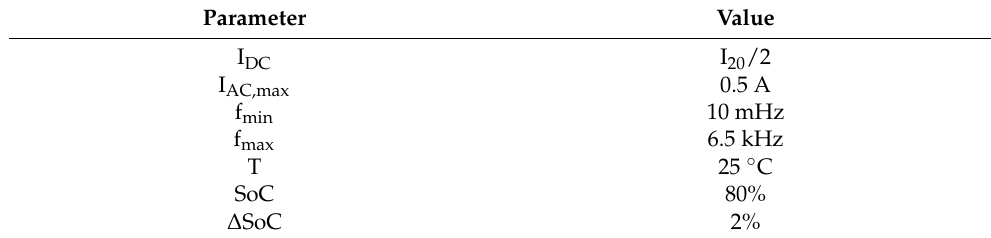
Table 2. EIS test parameters.